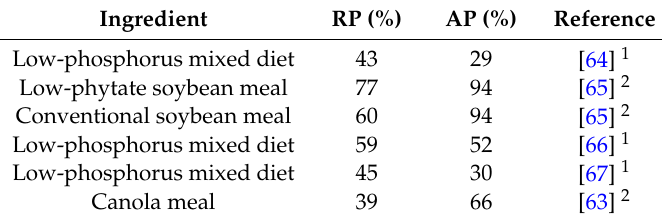
Table 2. Comparisons of retainable P (RP) with available P (AP) in the ileum of poultry [63]. Ingredient RP (%) AP